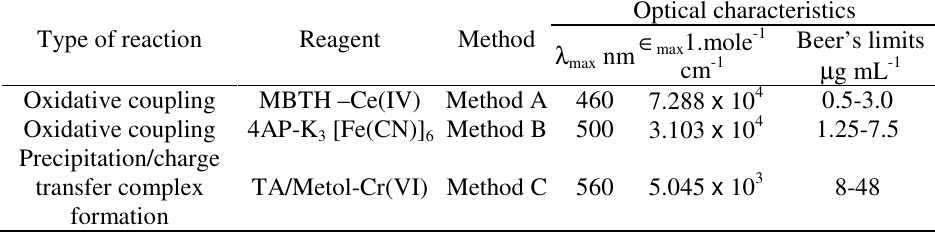
Table 1. List of proposed and reported visible spectrophotometric